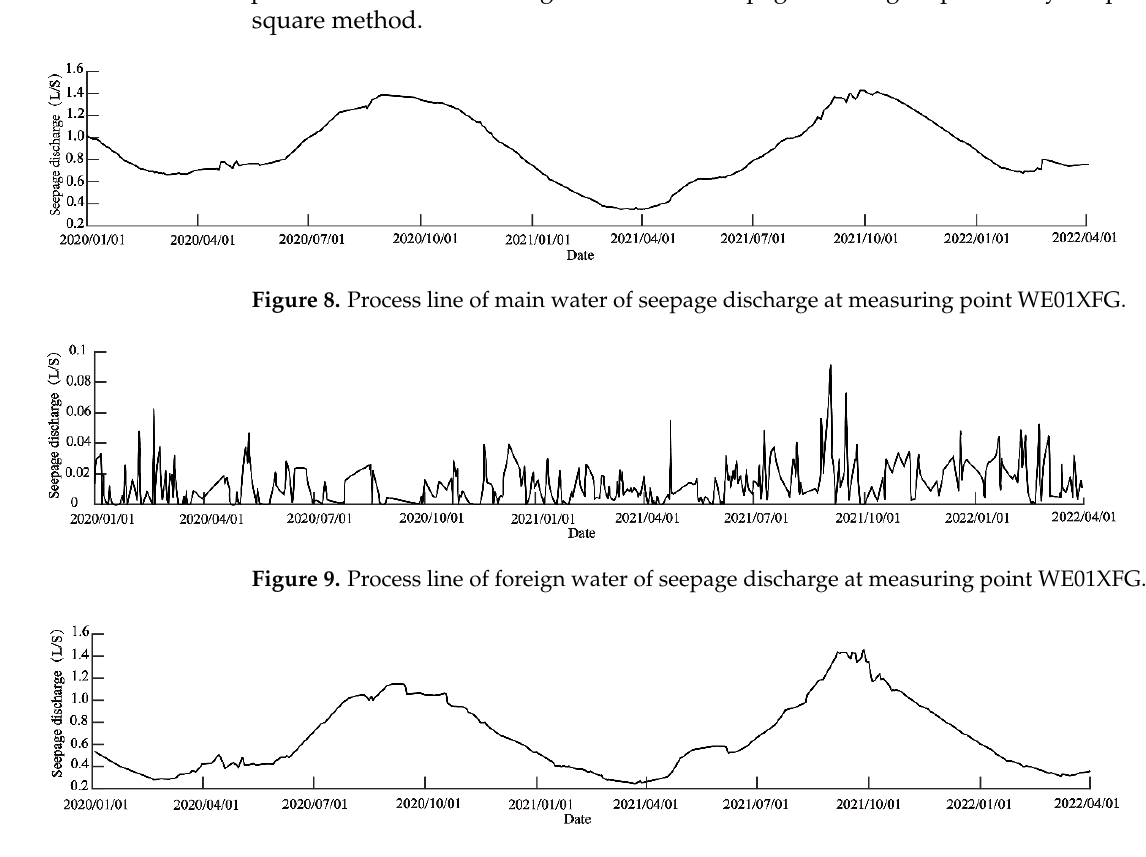
Figure 10. Process line of main water of seepage discharge at measuring point WE01YXD.